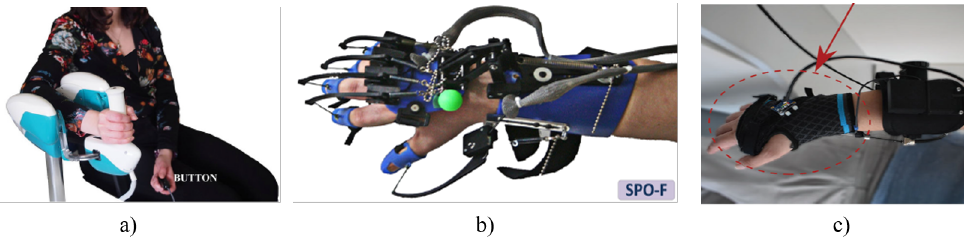
Figure 20. Different wrist exoskeletons focusing on portability: ( a ) Wristbot: a fixed wrist exoskeleton for rehabilitation, designed by Masia. Reprinted/adapted with permission from D’Antonio et al. [86], published by Frontiers in Neurorobotics, 2021; ( b ) SCRIPT: a hand/wrist exoskeleton prototype for rehabilitation, reprinted/adapted with permission from Ates et al. [53], published by Springer in Autonomous Robot, 2017; ( c ) a prototype wrist exosuit for working assistance reprinted/adapted with permission from Chiaradia et al. [54], published by Frontiers in Robotics and AI, Sec. Soft Robotics,